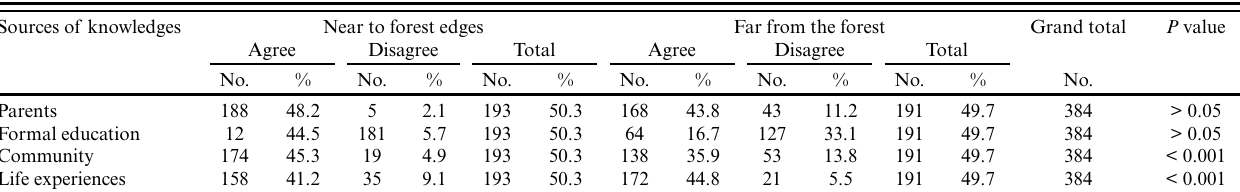
Table 4. Farmers’ responses regarding the source of knowledge about integrating trees with crops in their farmlands near to and far from forests. P values are from chi-square tests.